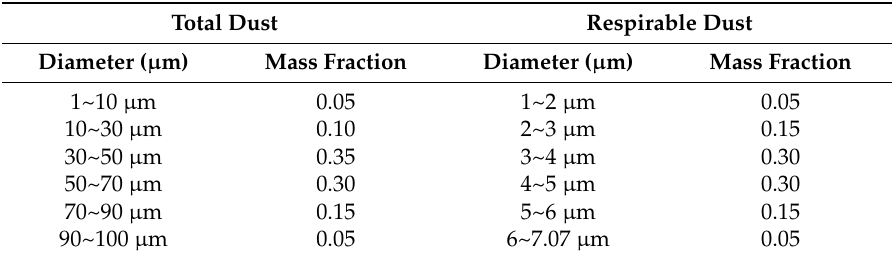
Table 4. Dust size distributions for full dust and respirable dust.